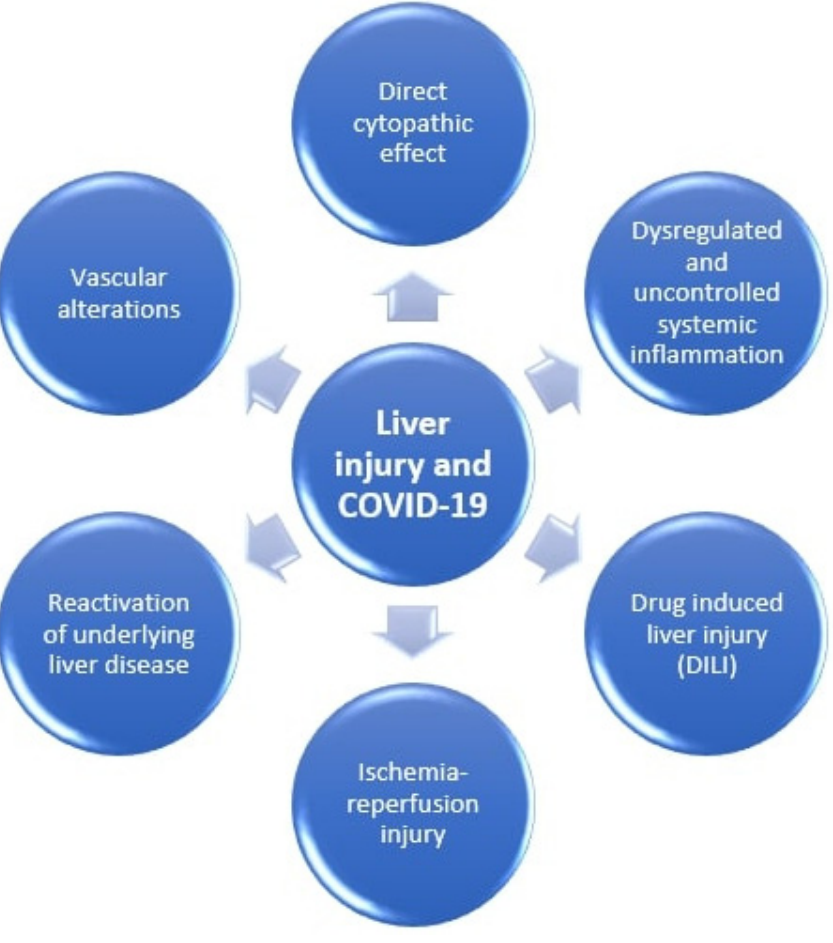
Figure 1. Mechanisms of liver injury in COVID-19.